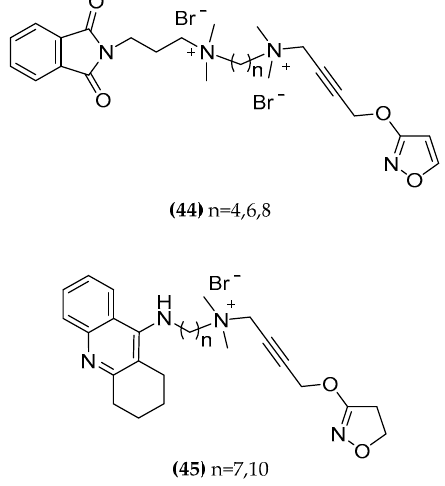
Figure 22. AChE inhibitor/ mAchR agonist compounds. Table 1. Cholinesterase activity and cytotoxicity of the M2 bitopic compounds and tacrine hybrids. BChE from equine serum, AChE from electric eel. [110].